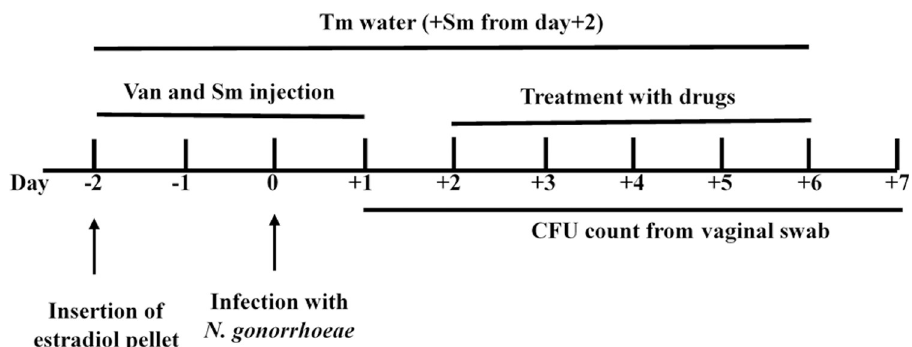
Fig 1. Schedule of the infection, treatment, and sample collection of N . gonorrhoeae in the female mouse model of genital tract infection. Two days before the infection, 8-week-old female ovariectomized BALB/c mice were implanted subcutaneously with a 5-mg, 21-day controlled-release estradiol pellet. Mice were given antibiotics (Tm, trimethoprim; Sm, streptomycin; Van, vancomycin) throughout the experiment, as described in the Materials and Methods section. Two days following vaginal infection, mice were allocated into groups and orally administered either auranofin (0.25 mg/kg) or vehicle (10% DMSO, 10% Tween 80, 80% PBS) for five days. One group of mice was given a single intraperitoneal dose of ceftriaxone (15 mg/kg) as a positive control. Vaginal swabs were collected daily. Samples were serially diluted and plated on GC agar supplemented with vancomycin, colistin, nystatin, and trimethoprim